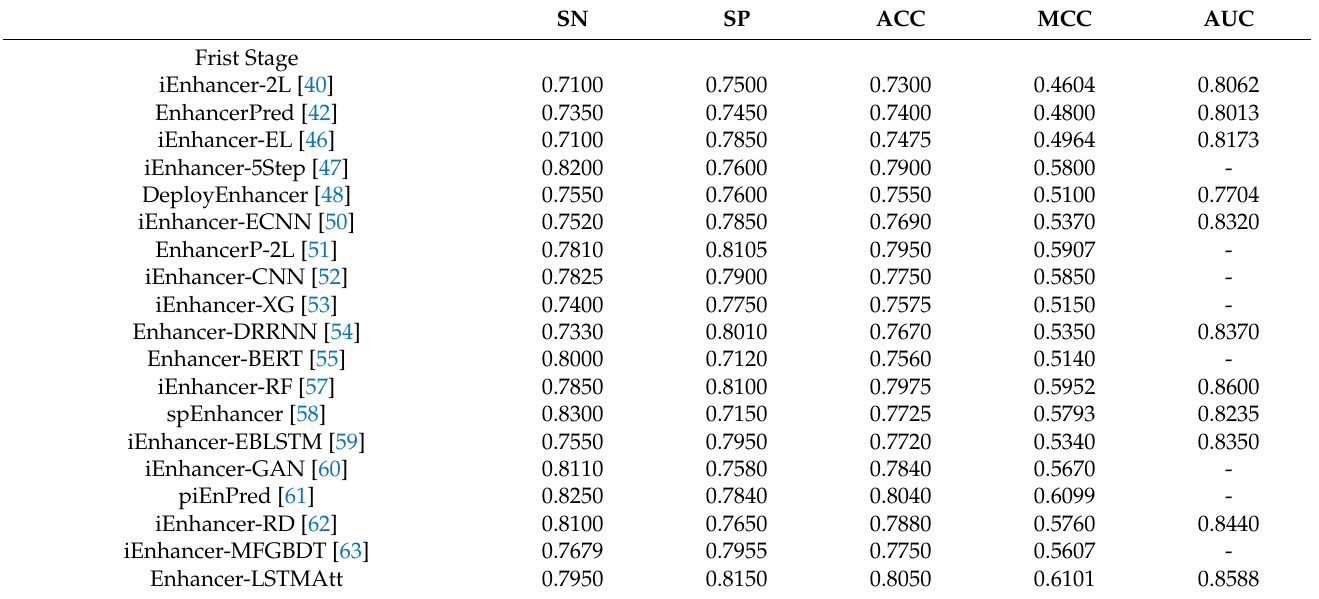
Table 6. Comparison with state-of-the-art methods by independent test. SN